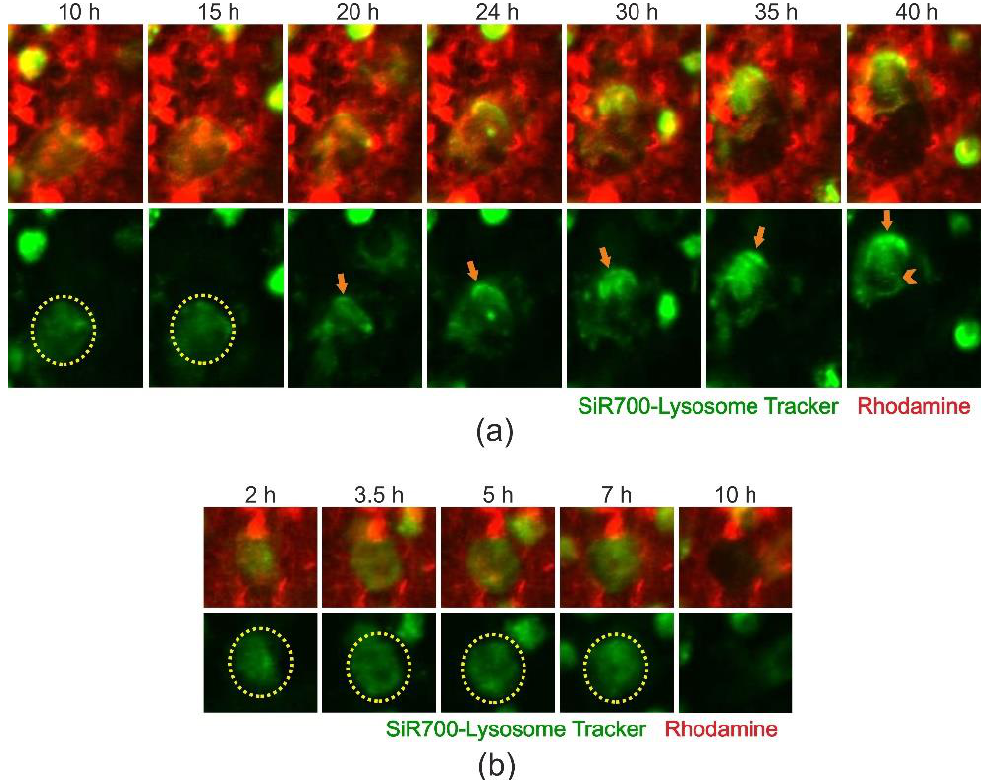
Figure 5. Time-lapse recording reveal that cathepsin D positive lysosomes show different abundance and transportation in OCs making trenches and pits. Images are selected snapshots from Supplementary Materials Movie 3 showing a 70 h time-lapse recording of resorbing OCs labelled with SiR700-Lysosome Tracker on rhodamine coated bovine bone slices. ( a ) An OC initially making a pit (yellow circle) and subsequently switching into trench mode resorption. Orange arrows indicate the resorption front while the orange arrow-head highlights where the lysosomes are transported to at the rear end of the OC. The width of each image is 72.4 µm. ( b ) An OC only making a pit. Cathepsin D-positive vesicles are distributed equally within the boundaries of the cavity (yellow circle) without any signs of polarization. The width of each image is 56.6 µm.